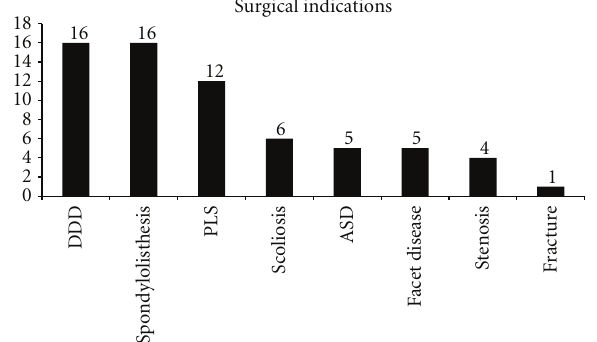
Figure 2: Graph showing the number of patients with each indication.